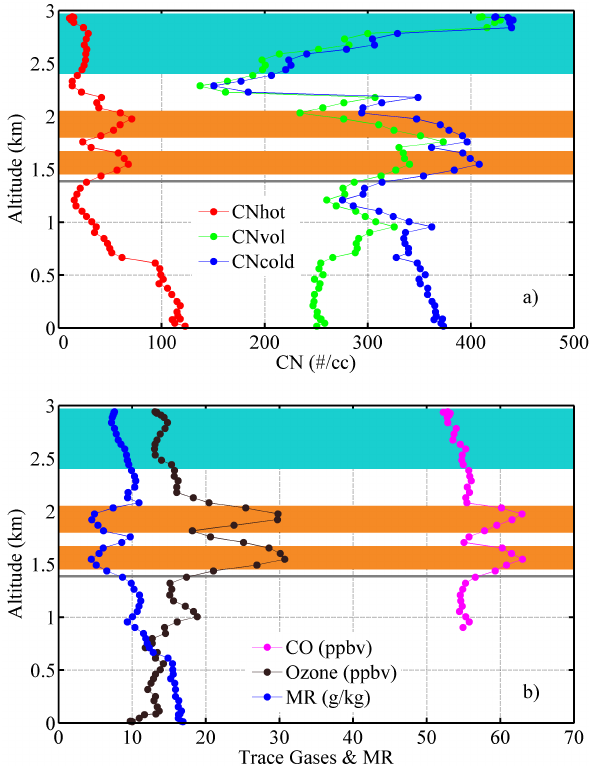
Fig. 1. Ascent around 19:00UTC, 10 August, illustrating typical Fig. 1: Ascent around 19:00 UTC, 10 August, illustrating extent and strength of pollution (orange shading) and cloud outflow typical extend and strength of pollution (orange shading) and (cyan) layers above the TWI (grey line) for various tracers. cloud outflow (cyan) layers above the TWI (grey line) for various tracers. 10 August around 19:00 UTC (Fig. 1). A convective cloud outflow layer is marked in cyan shading between approxi- 1500 and 2000 m are shaded in orange, while the TWI height et al., 2009) is shown as a solid grey line. Similar pollu- FT during PASE and are discussed elsewhere ( Clarke et